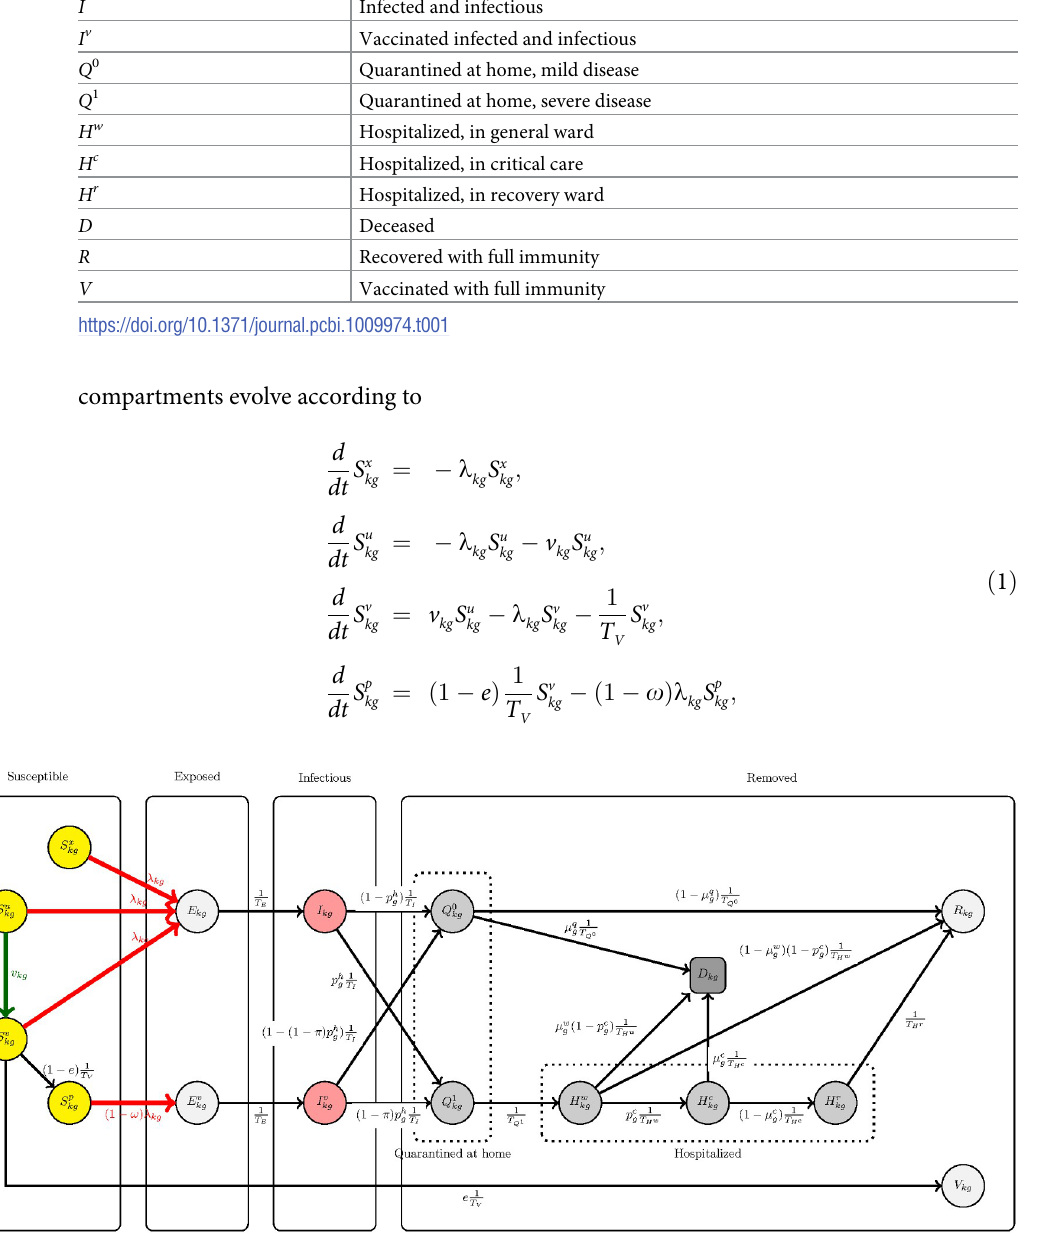
; S v ; ... ; V for kg kg kg